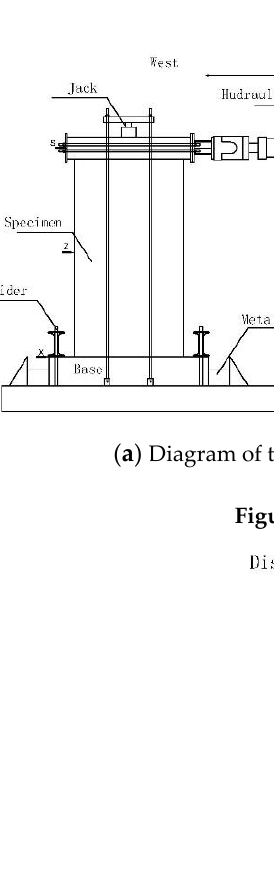
Figure 5. Loading